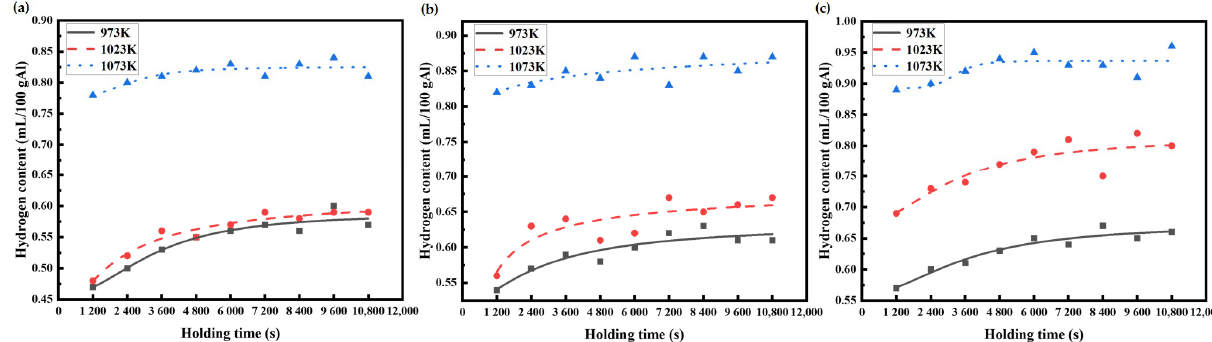
Figure 4. Variation in hydrogen content in AA6111 alloy melt at the same humidity and different temperature: ( a ) RH 30%, ( b ) RH 50%, ( c ) RH 80%.